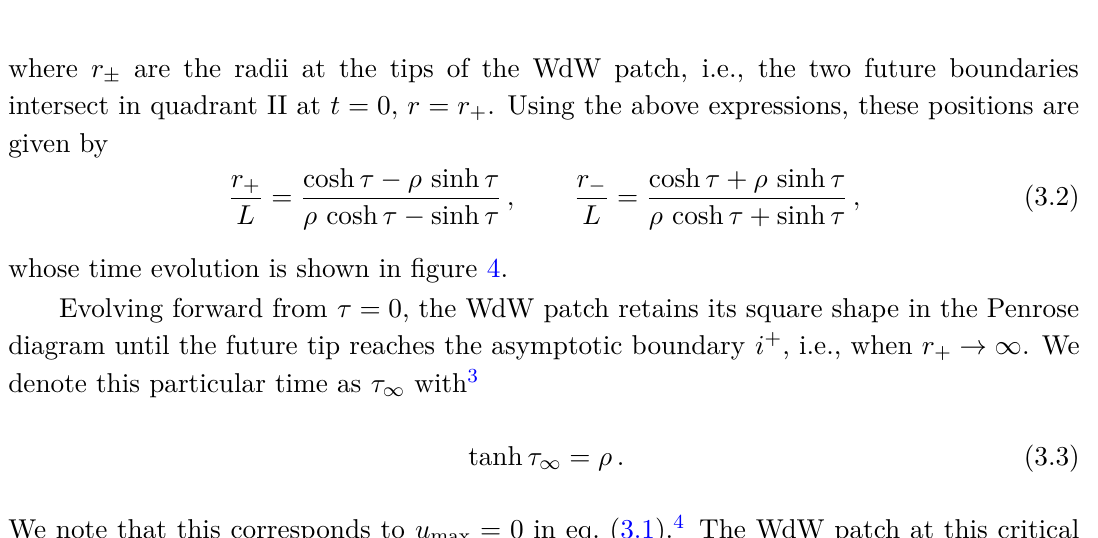
Figure 3 . The orange square region denotes the WdW patch at a boundary time t The purple dashed curves represent the stretch horizon at r = ρL . Left: the WdW patch at τ = 0 . Right: the WdW patch at the critical time τ = τ ∞ where the future tip F touches i + . The shadowed blue region presents the WdW patch at τ = 0 with exactly anchoring the boundary at the south and north poles (i.e., ρ = 0